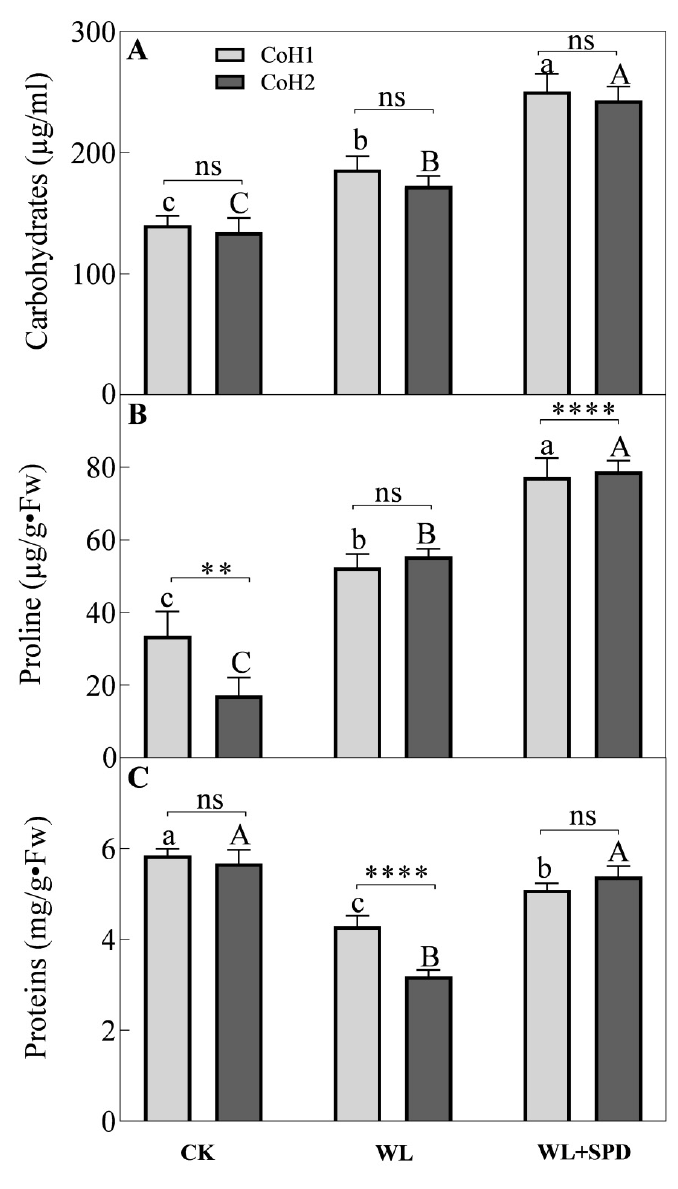
Figure 4. Carbohydrates ( A ), proline ( B ), and soluble proteins ( C ) contents in C . oleifera under WL stress exposed to SPD. The bars on the top show SE (n = 5), and different lowercases and uppercases indicate significant differences among CK, WL, and WL + SPD treatments within each species according to Tukey’s multiple comparison test, respectively ( p < 0.05). The signs such as **** , ** and ns in the figures concern the significance difference between the same treatment for CoH1 and CoH2 (****, p < 0.0001; **, p < 0.005; ns , Not significant). CK: control; WL: waterlogging; SPD: